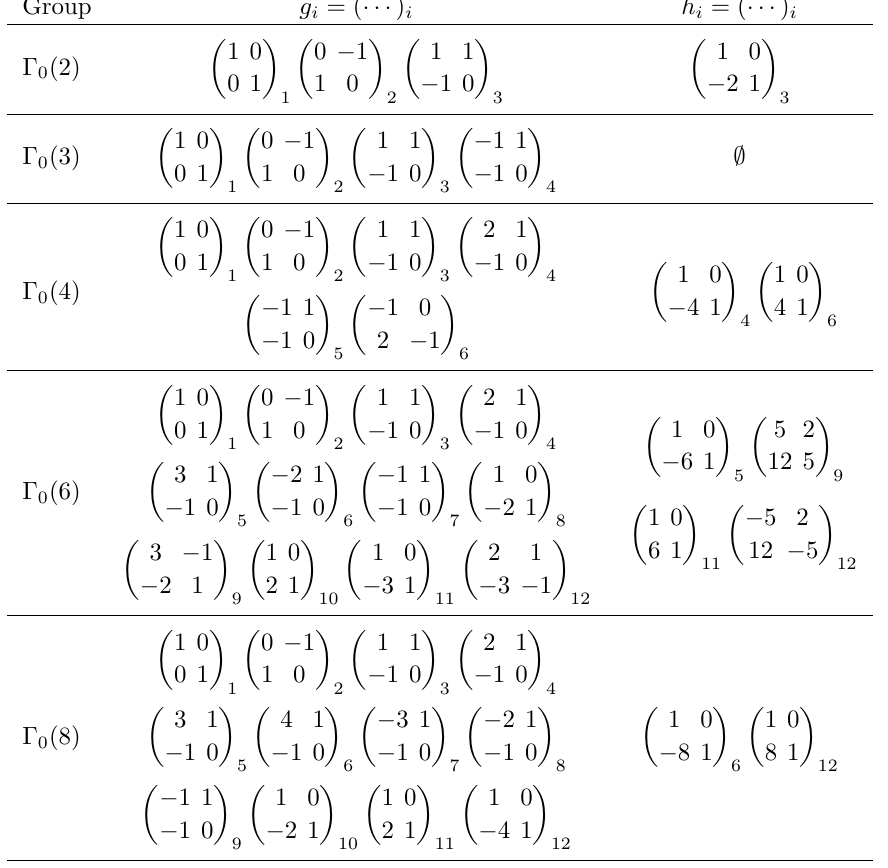
Table 3 . Coset representatives g i and glueing transformations h i for some selected Γ 0 ( N ) . The table is continued at